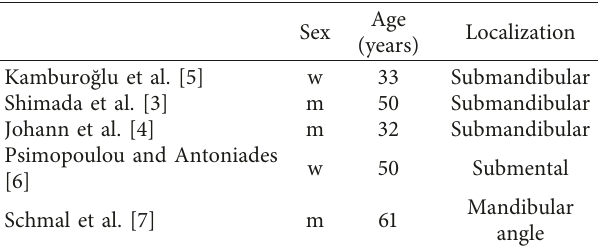
Table 1: Overview of the cases of osseous choristoma in the cervical soft tissues published in the literature. The table shows that all of the previous described lesions have been found in the submandibular or submental